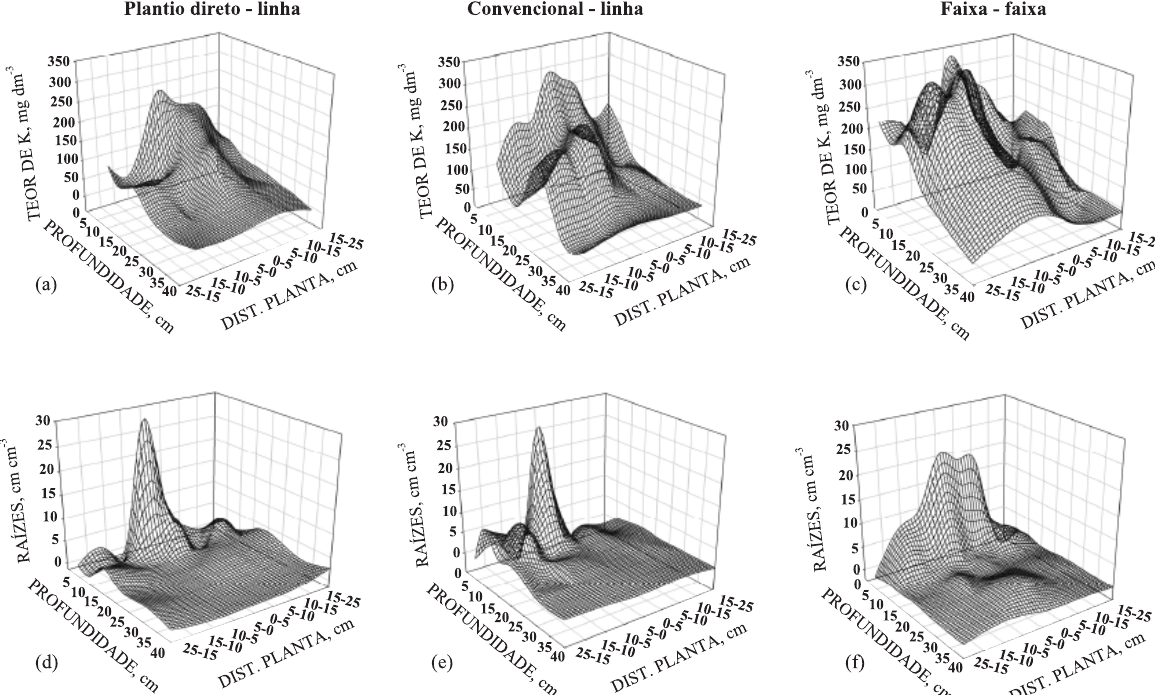
Figura 5. Distribuição de potássio (a, b e c) e de raízes (d, e e f) no início do enchimento de grãos de milho, no perfil de um Argissolo Vermelho sob os sistemas de manejo: plantio direto-linha, convencional-linha e preparo em faixa-faixa, respectivamente, por 18